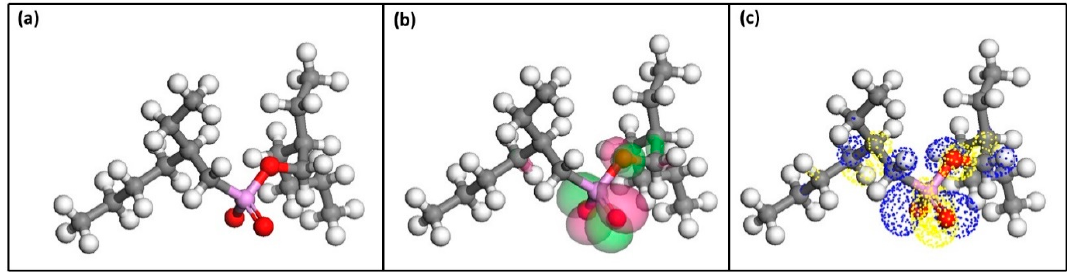
Figure 5. ( a ) Optimised structure of PC88A, ( b ) distribution of highest occupied molecular orbitals (HOMOs) of PC88A, and ( c ) distribution of lowest unoccupied molecular orbitals (LUMOs) of PC88A.